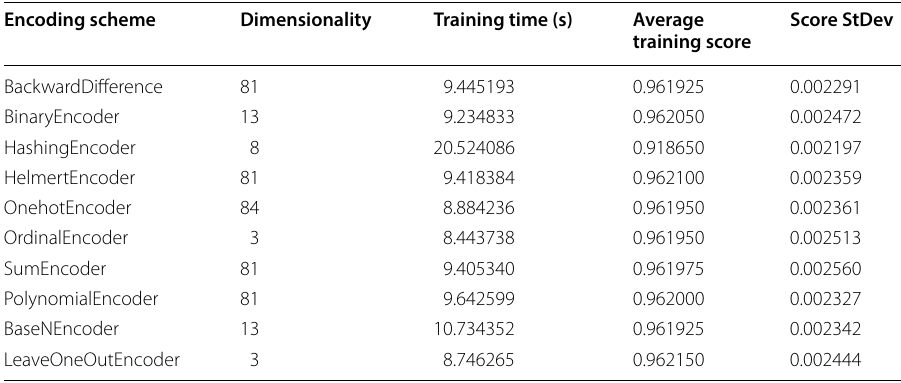
Table 4 Table comparing Random Forest accuracy for various encoding techniques, reproduced from [62]